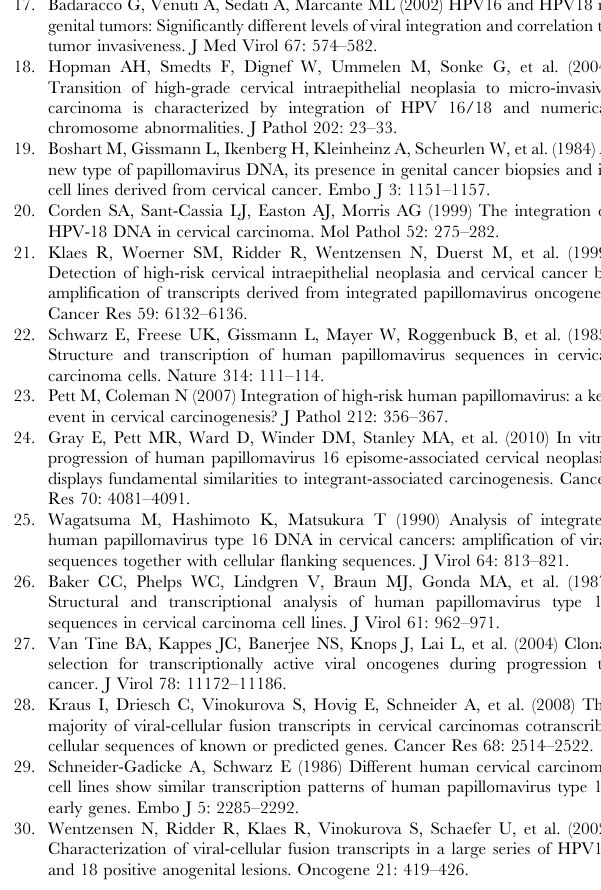
Figure S1 Distribution of read pair numbers for the TEN16 junctions tested by junction-PCR. Altogether 84 junctions (75 authentic as filled bars and 9 false-positive as open bars) are shown arranged by increasing numbers of read pairs, and for each junction a serial number was designated accordingly. The read pair numbers are shown in log scale. The dashed line indicates the cutoff level of 15 read pairs. Identification of the seven junctions below the cutoff is explained in the main text. For DNA junction 3966_DJ1 (serial number 1, labeled with asterisk), the first-round data analysis did not produce any read pair. In the second analysis at low stringency (see Materials and Methods), 155 read pairs of this junction were detected. Table S1 HPV16 forward primers for TEN16. Table S2 Barcoded Nextera adapter sequence. Table S3 HPV16-cellular DNA junctions validated by junction-PCR (sorted by sample ID). Table S4 Frequency distribution of HPV16 3 9 -break- points of viral-cellular DNA junctions in different segments of the HPV16 early region.